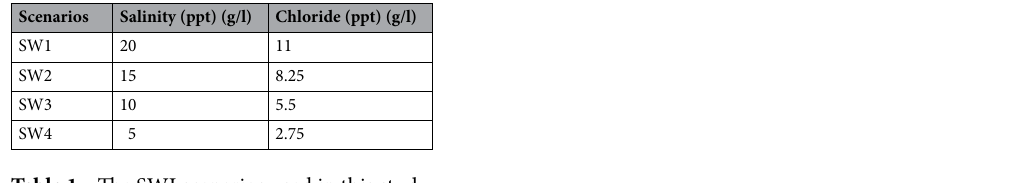
Table 1. The SWI scenarios used in this